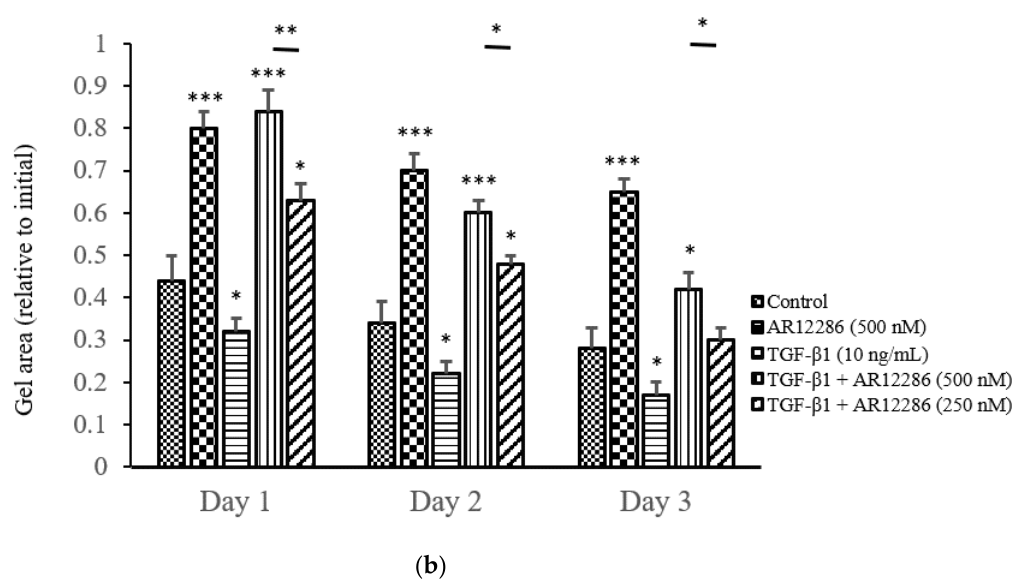
Figure 6. Effect of AR12286 on gel contraction. ( a ) Control, AR12286-treated, TGF- β 1-induced and 250 nM AR12286-treated, and TGF- β 1-induced and 500 nM AR12286-treated collagen gels incubated for up to 3 days. ( b ) Contracted extent of collagen gels mediated by HConFs expressed as gel size based on initial area. Gel size (relative to initial) measured in absence (control) or presence of AR12286 at 250 and 500 nM. Control group exhibited gradual decrease in gel-size ratio: 0.43 (Day 1), 0.35 (Day 2), and 0.25 (Day 3). TGF- β 1-treated group exhibited significantly more intense contraction than the control group did from Days 1 to 3 ( p < 0.05). Data presented as means ± SEM ( n = 6). Single asterisk indicates statistical difference compared with control group. Asterisks indicate the following significantly different responses: *, p < 0.05; **, p < 0.01; and ***, p < 0.001.